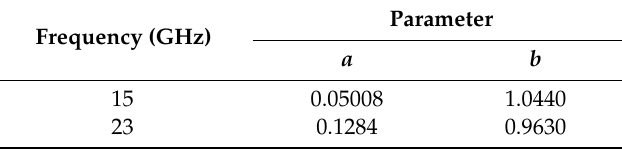
Table 2. a and b parameters used for estimating R from Z